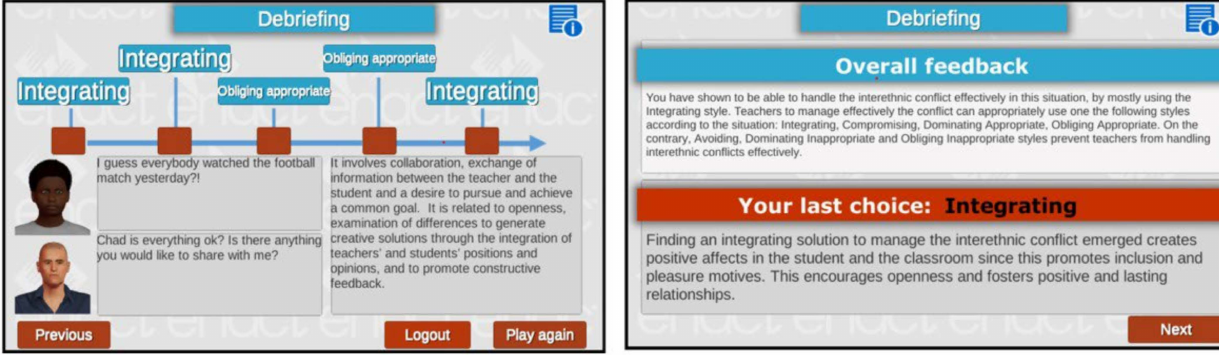
Figure 3. ACCORD debriefing